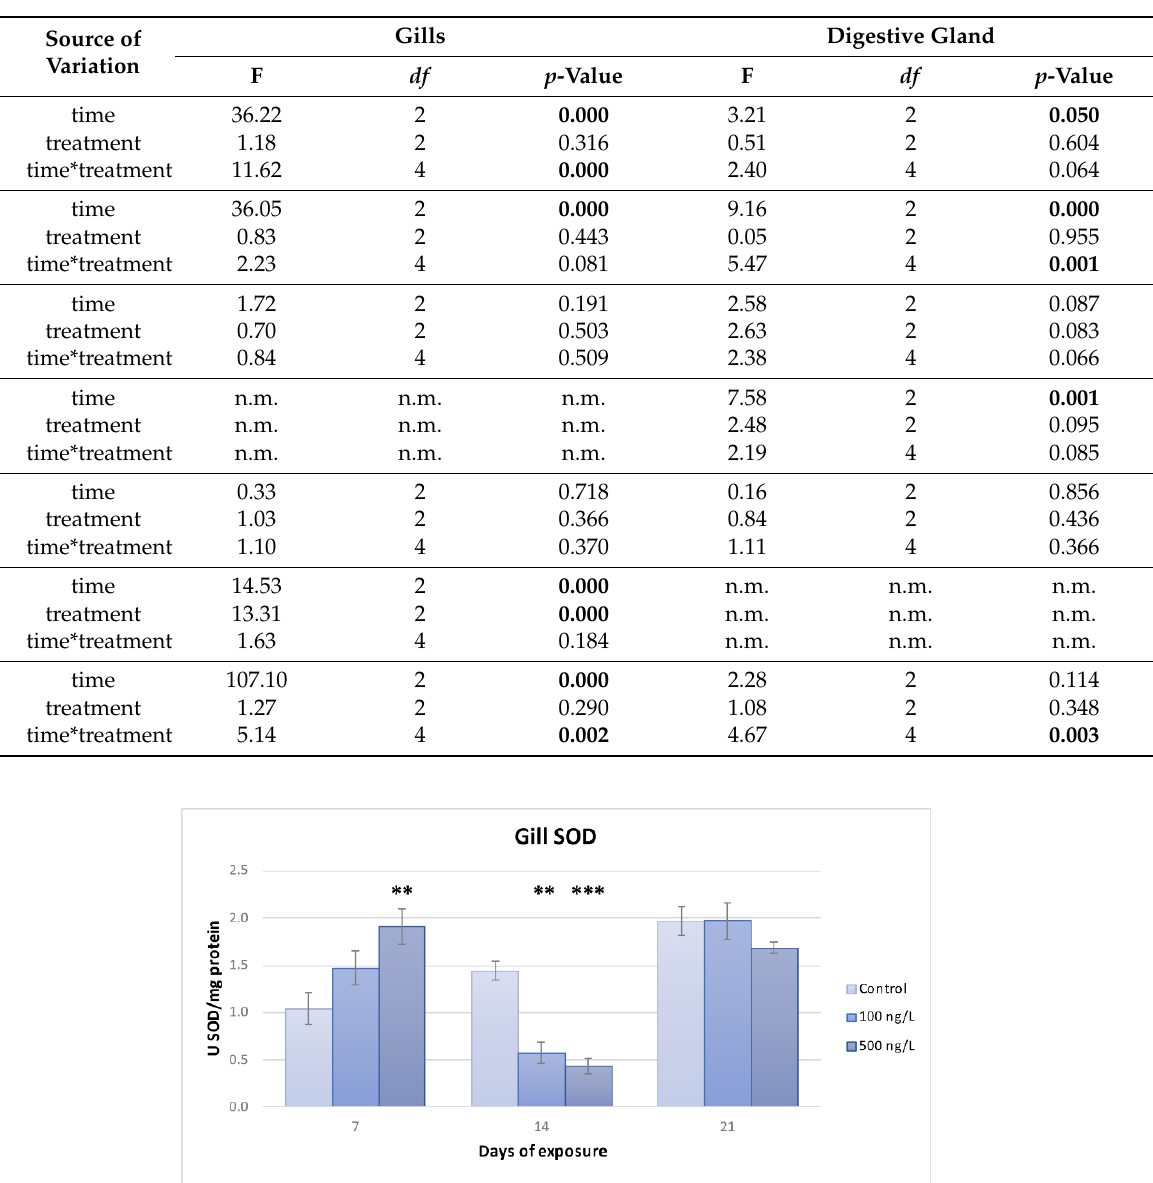
Figure 3. Superoxide dismutase activity in the gills of Ruditapes philippinarum after exposure for 7, 14 and 21 days to 100 ng/L and 500 ng/L of HHCB. The results are expressed as U/mg of proteins and are reported as means ± standard error; n = 6. Asterisks indicate significant differences compared to controls at the same time of exposure: ** p < 0.01, *** p < 0.001.